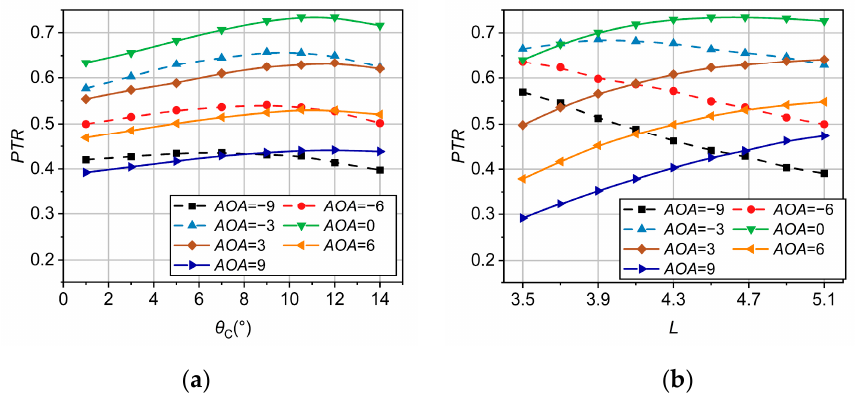
Figure 8. Evolution of the total pressure recovery at off-design AOA with varying ( a ) the inlet length; and ( b ) the cowl internal angle.